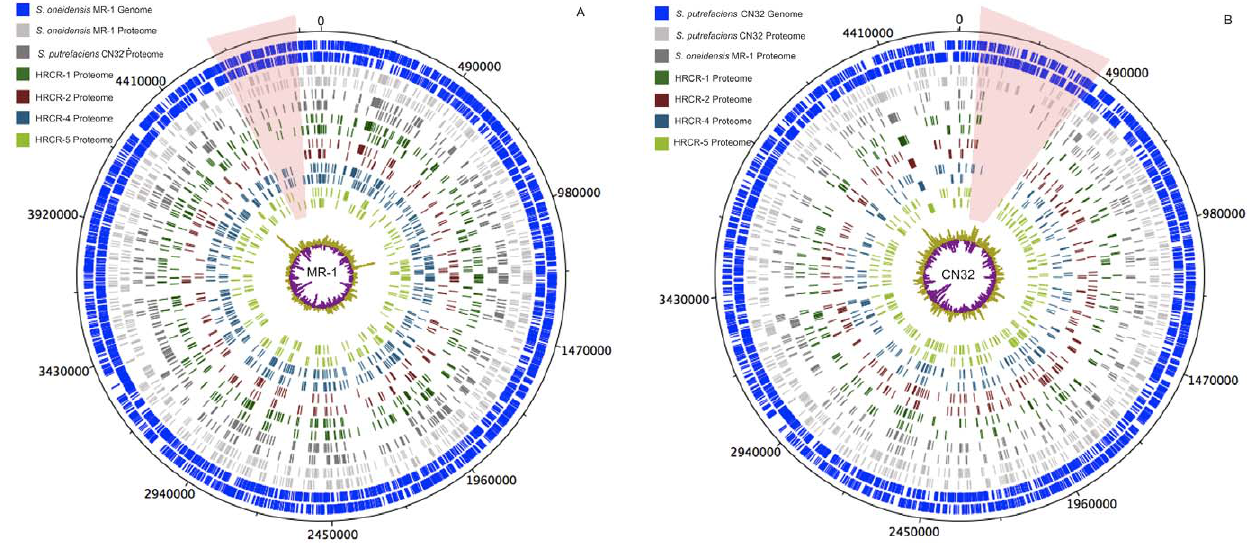
Figure 4. Protein identifications from the Columbia River isolates are mapped to the reference genomes S.oneidensis MR-1 (panel A) and S.putrefaciens CN32 (B). While all organisms were grown under the same conditions, observation of no protein expression compared to the reference proteome reveals that these organisms have undergone evolutionary divergence, which is reflected in protein expression. Also shown are the protein identifications for each of the Shewanella species mapped onto their respective genomes, as well as the protein orthologs across species. Two regions of ‘missing’ proteome information from the Hanford Reach isolates are highlighted.